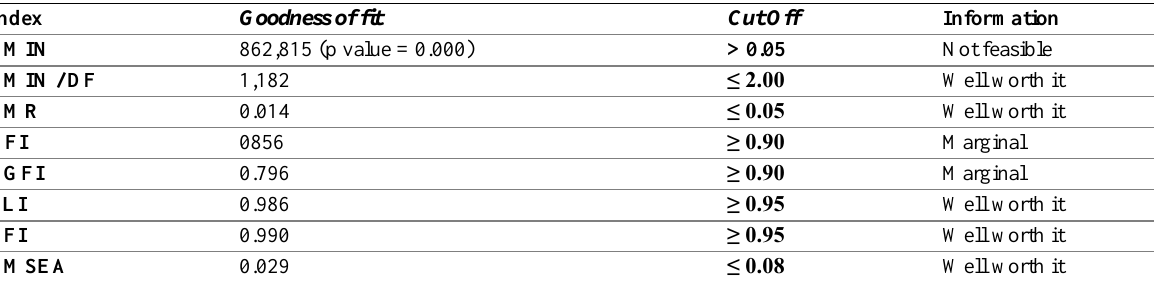
Table 7: Model Modification Results